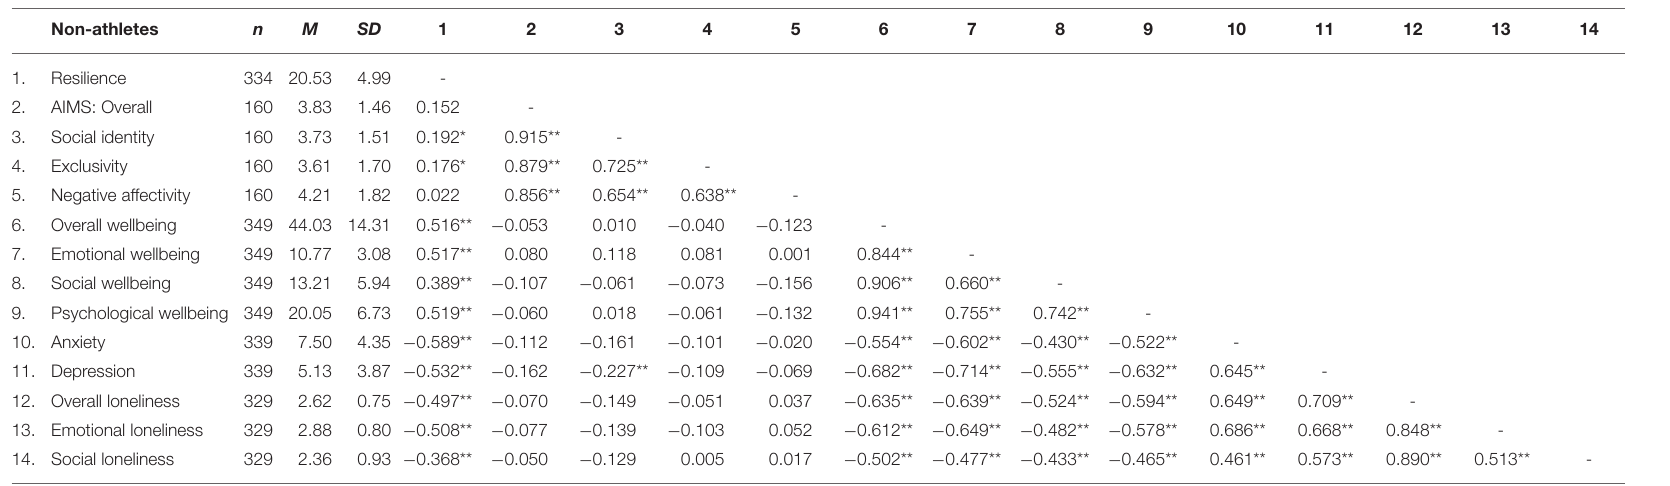
TABLE 3 | Descriptive statistics and correlations for